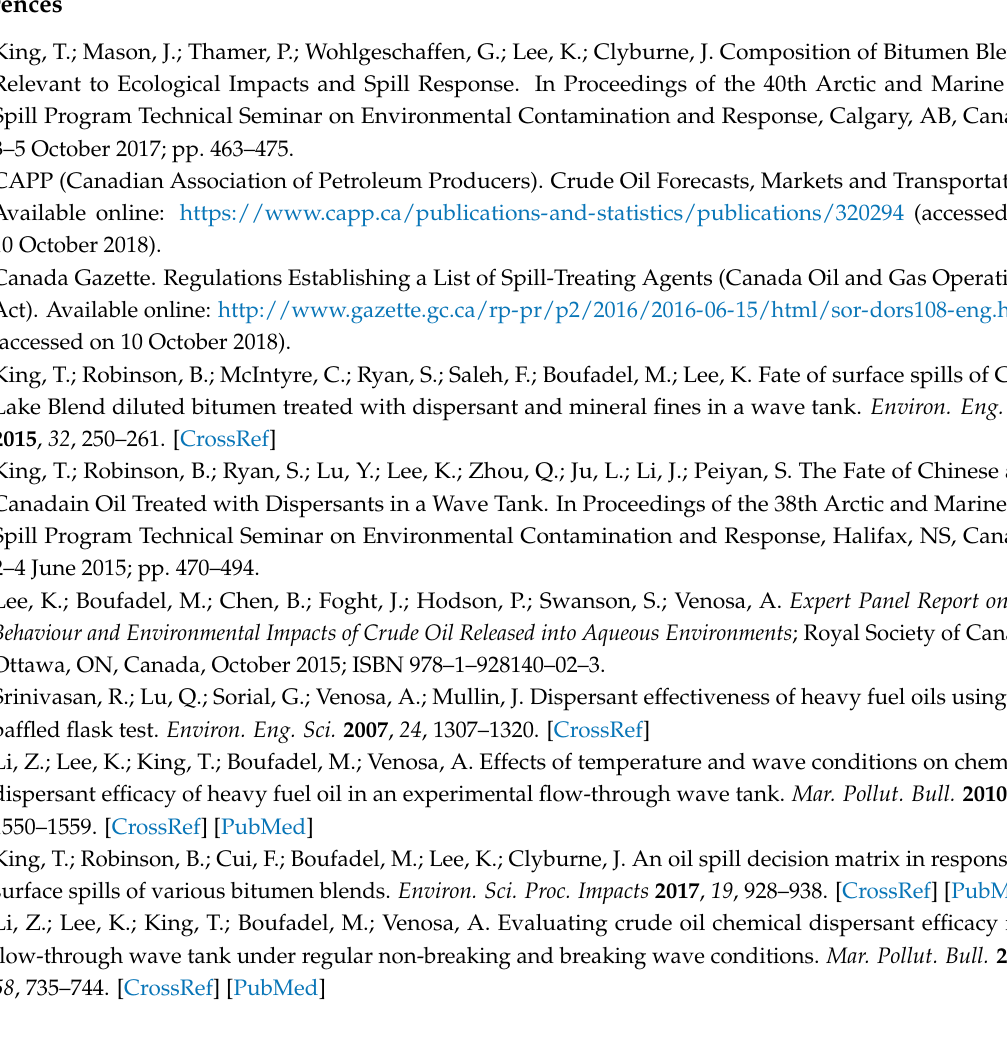
Table S1: Summary of test conditions, physical properties of test oils, and dispersion effectiveness measurements; Table S2: Predicted viscosity data generated from oil weathering (Equation (2)) and dispersion effectiveness (Equation (3)) models; Figure S1: The plot represents the seasonal effect on particle size distribution data (LISST 100X-#1; 1.2 m from oil release) obtained at the point in time of maximum total particle concentration during the natural dispersion of four oils; Figure S2: The plot represents the seasonal effect on particle size distribution data (LISST 100X-#2; 12 m from oil release) obtained at the point in time of maximum total particle concentration during the natural dispersion of four oils; Figure S3: The plot represents the seasonal effect on particle size distribution data (LISST 100X-#1; 1.2 m from oil release) obtained at the point in time of maximum total particle concentration during the chemically enhanced dispersion of four oils; Figure S4: The plot represents the seasonal effect on particle size distribution data (LISST 100X-#2; 12 m from oil release) obtained at the point in time of maximum total particle concentration during the chemically enhanced dispersion of four oils; Figure S5: Contour plots (LISST 100X-#1; 1.2 m from oil release) illustrating seasonal effect on the concentration of oil particle sizes simulated in the wave tank for the natural dispersion of four oil